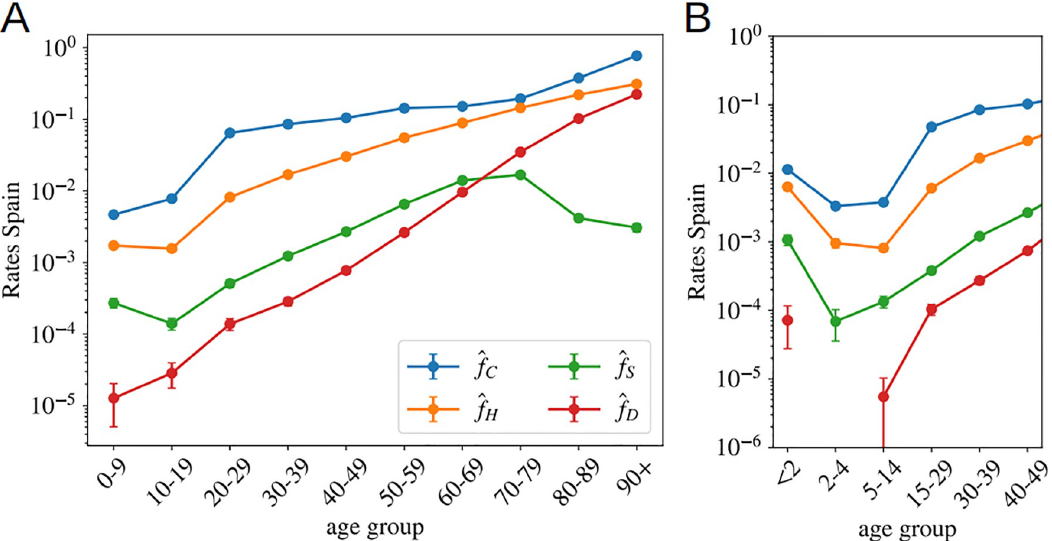
Fig 5. Other probabilities as function of age assuming uniform attack rate. In A we show the probability of being classified as official case, ^ f , being hospitalized, ^ f , admitted in intensive care, ^ f , and dying, ^ f , in Spain in Spring 2020, as function of the age C H S D using age segments of 10 years. B , we show the same data but were the kid’s information has been grouped by smaller age-segments, evidencing the severity of the cases in patients under 2 years old. A is generated using the data by the Spanish Health Ministry up to the 22nd of May and B with the data published by the RENAVE, see Materials and S1